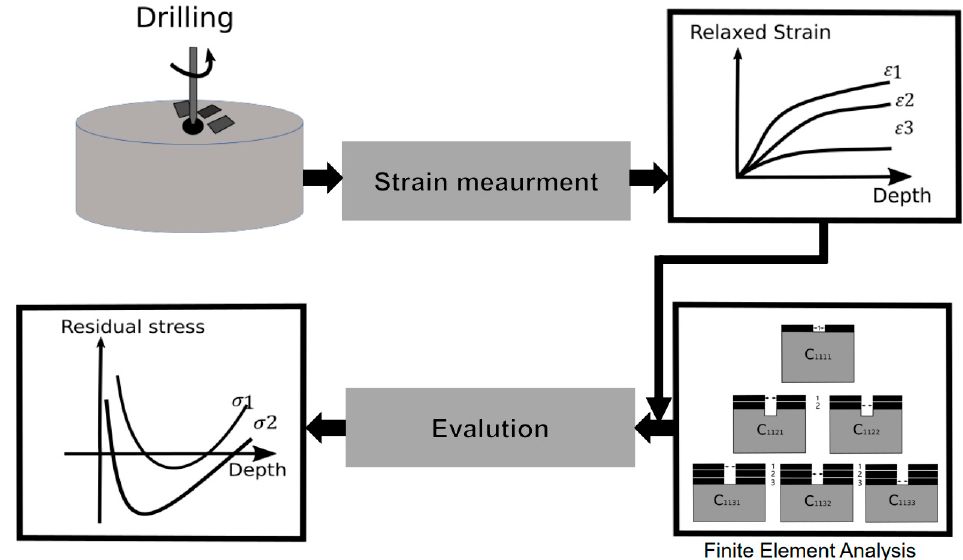
Figure 1. Framework of measuring the residual stresses by the hole ‐ drilling method.